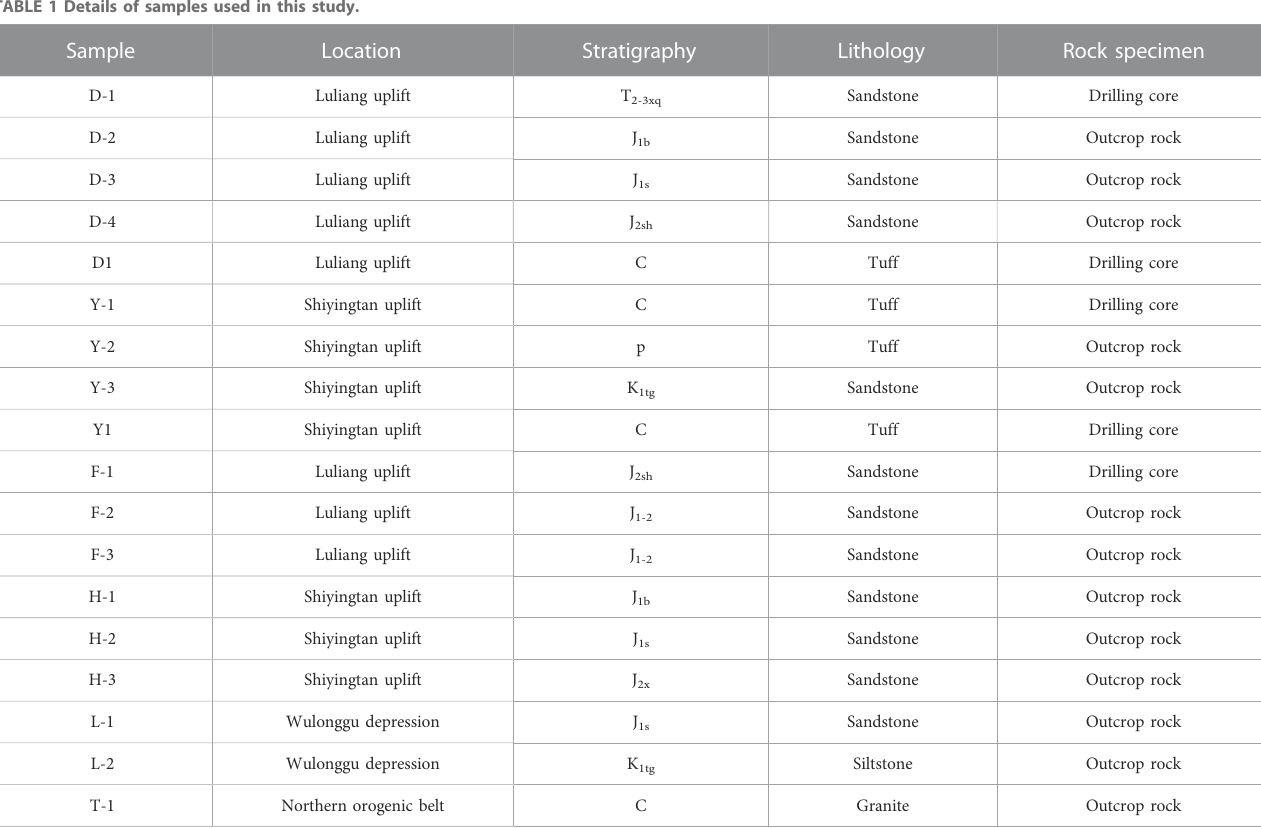
TABLE 1 Details of samples used in this